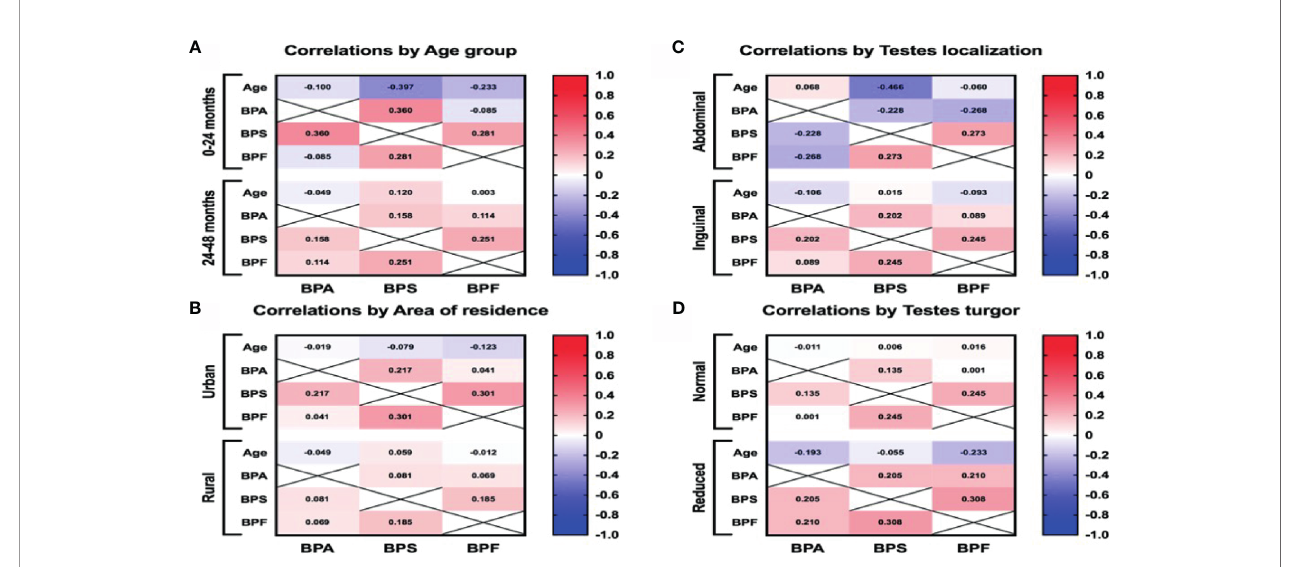
FIGURE 3 | The Pearson correlation between BPs plasma levels and age (A) , area of residence (B) , intraoperative testes localization (C) , and testes turgor (D) . Red and blue colors indicate positive and negative correlations, respectively. The deeper the color the more signi fi cant is the corresponding